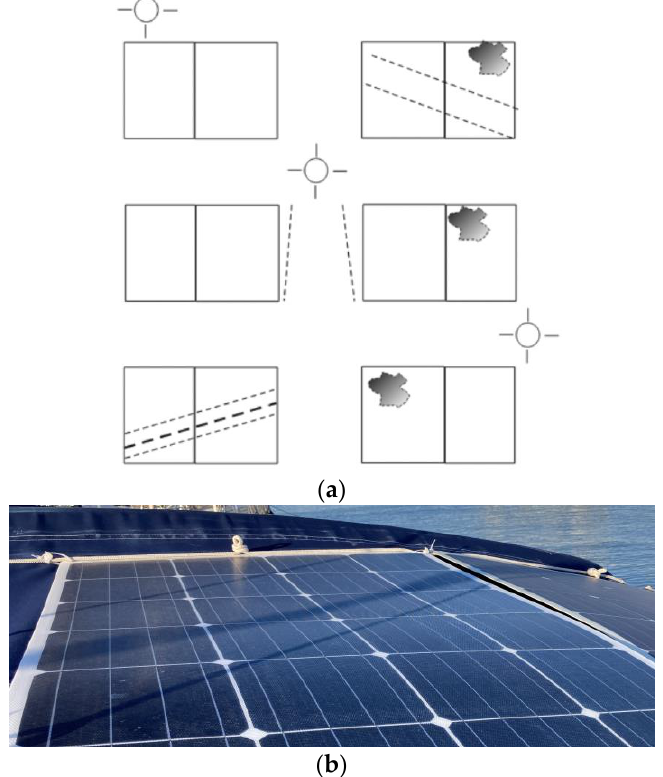
Figure 15. Displacement of the dashed lines and irregular shading areas according to the daily movement of the sun from east to southwest: ( a ) schematic diagram; ( b ) actual assembly. The test was carried out last 30 April from 6:30 a.m. to 5:30 p.m. (UTC), during which